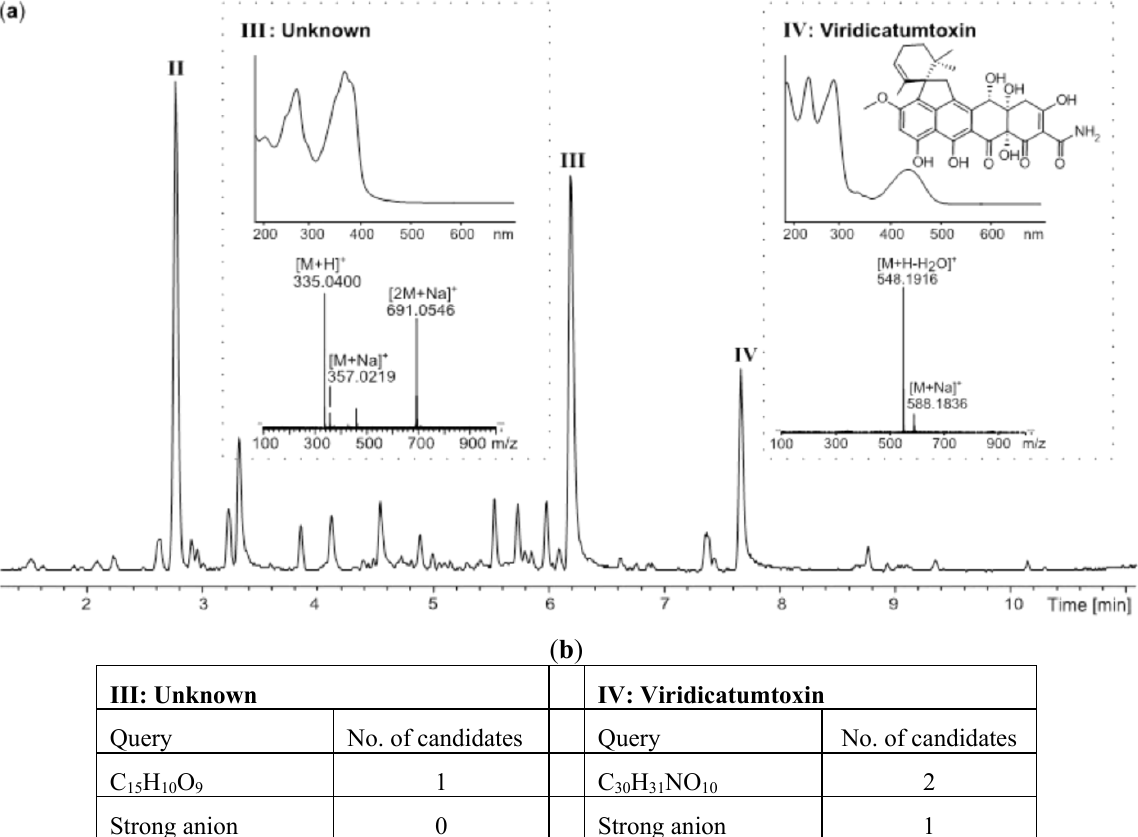
Figure 4. Dereplication of the P . brasilianum extract ( a ) UHPLC chromatogram of the active SAX fraction that contained the acidic compounds as well as UV and MS spectra of the potential candidates; ( b ) Hits in